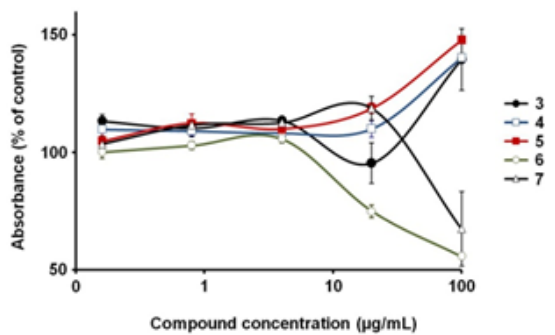
Figure 3. Cytotoxicity of the isolated compounds. The cytotoxicity of the isolated compounds was evaluated in human skin fibroblasts using the MTT-method, as described in the Materials and Methods. Results are expressed as a percentage of the control and represent the mean of three independent experiments performed in quadruplicate.